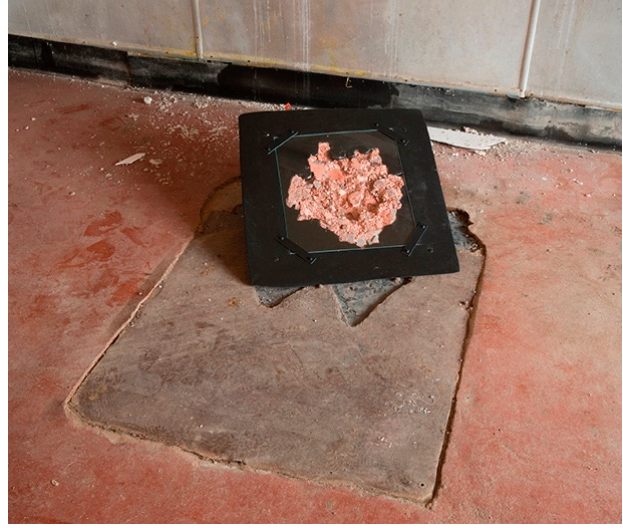
Figure 12. Matthias. 2016. Shraff , featured in S-O-T Body Repairs exhibition.